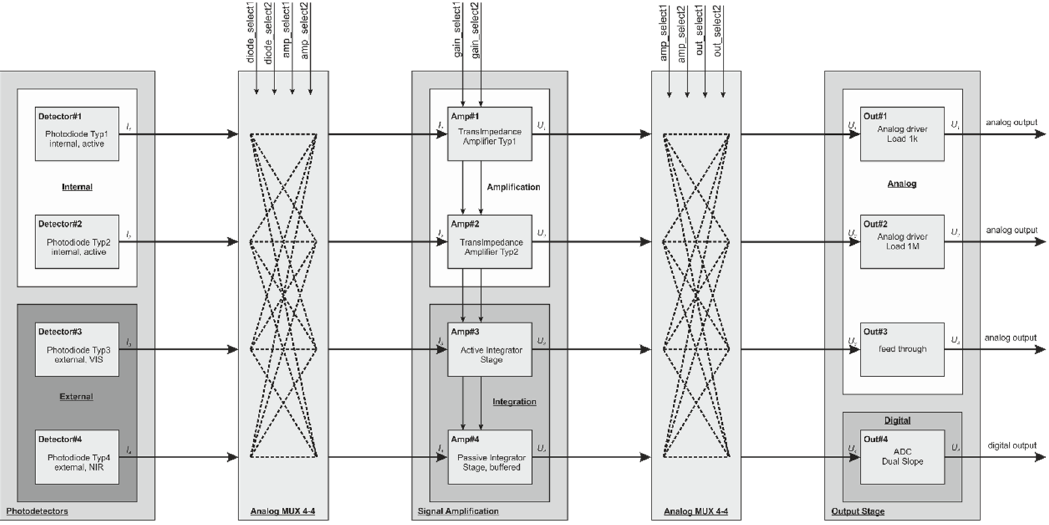
Figure 1. Universal Integrated Photodetector Platform—Functional block